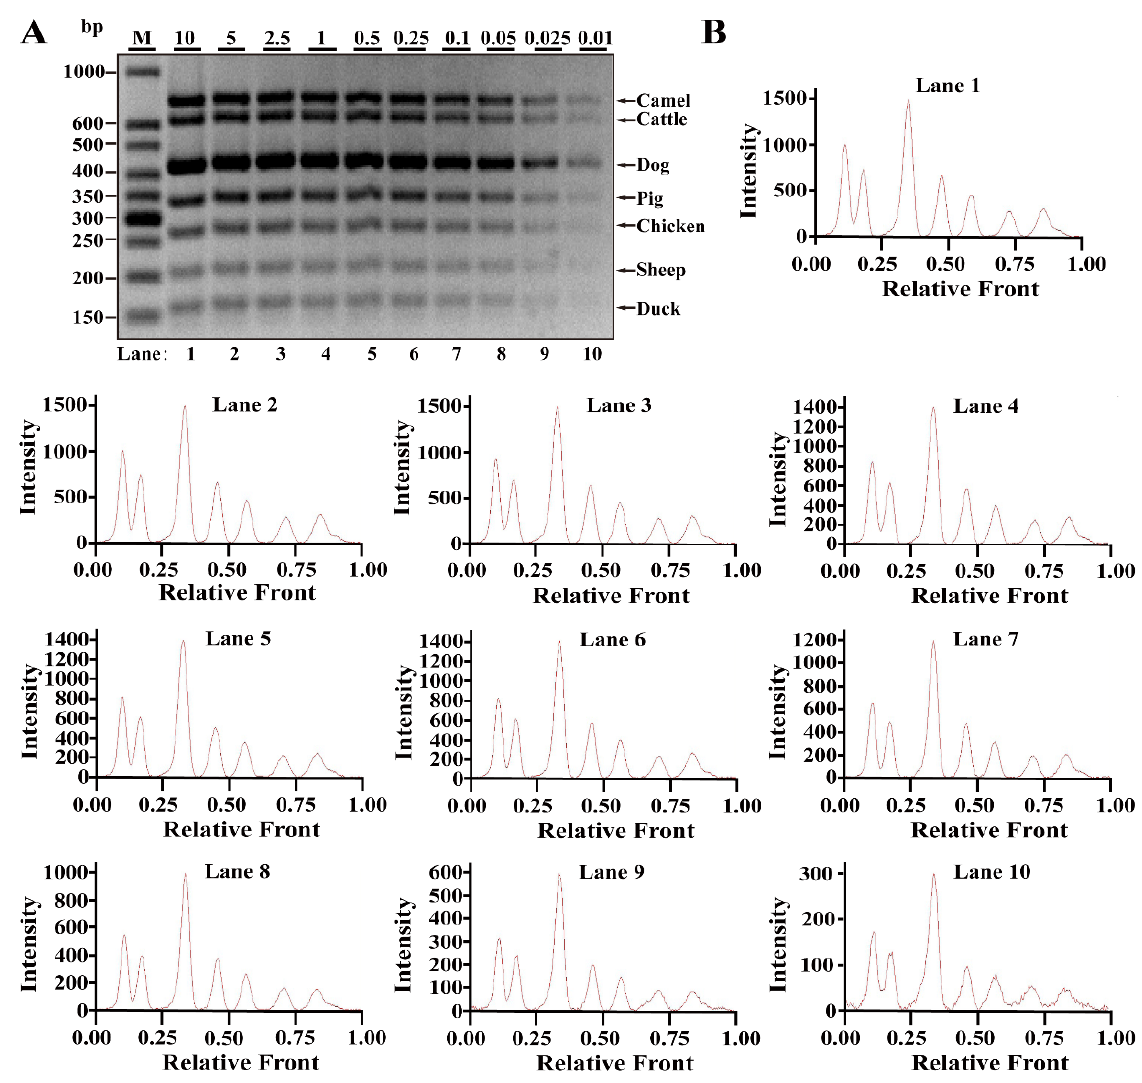
Figure 2. Validation of sensitivity of multiplex PCR assay in raw meat tissues. ( A ) Gel image of PCR fragments amplified by multiplex PCR using premixed DNA contents of seven species (10, 5, 2.5, 1, 0.5, 0.25, 0.1, 0.05, 0.025 and 0.01 ng) with seven sets of species-specific primers, respectively. ( B ) The corresponding electropherograms represent camel, cattle, dog, pig, chicken, sheep and duck in each lane. Lanes 1–10 are presented with labels of 10, 5, 2.5, 1, 0.5, 0.25, 0.1, 0.05, 0.025 and 0.01 in ( A ). The value of number at the horizontal line means the relative position of peaks distant from the top of agarose gel. The value of number at the vertical line means the fluorescent intensity of DNA-bound dyes (4 S GelRed Nucleic Acid Stain). Lane M is ladder DNA.